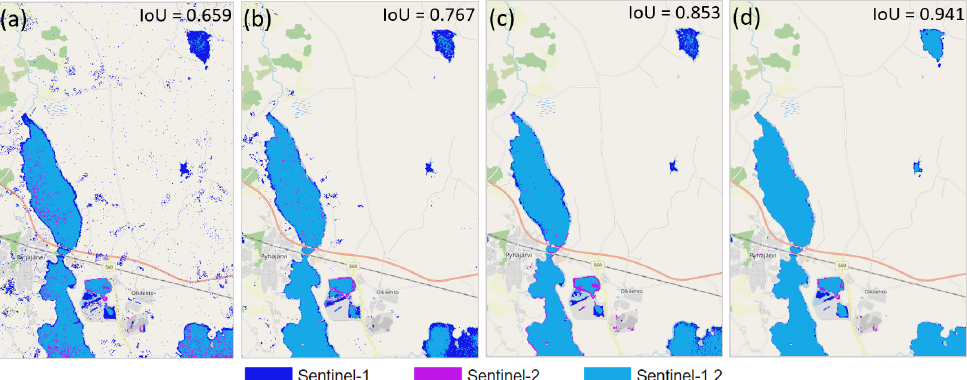
Figure 3. Maps of optical and SAR masks of surface water bodies with different IoU values: ( a ) 23 May 2019, path 153, VV polarization, MNDWI , without speckle filtering ( IoU = 0.659); ( b ) 28 May 2018, path 160, VH polarization, NDWI , Median 3 × 3 speckle filtering ( IoU = 0.767); ( c ) 23 May 2019, path 153, VH polarization, NDWI , Lee 7 × 7 speckle filtering ( IoU = 0.853); ( d ) 28 August 2021, path 160, VH polarization, MNDWI , Median 7 × 7 speckle filtering ( IoU = 0.941). Basemap: OpenStreetMap